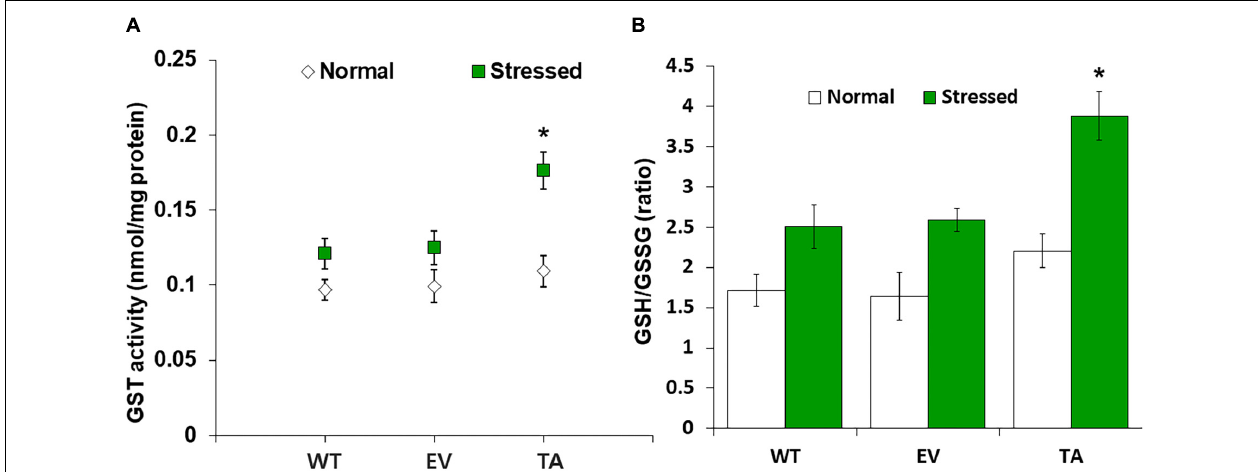
FIGURE 5 | Analysis of enzyme activity and antioxidant redox status in TA after H 2 O 2 treatment. (A) Activity of GST under normal and stress conditions. (B) Intracellular GSH/GSSG redox ratios in WT, EV, and TA after exposure to 2.5 mM H 2 O 2 for 24 h. White bars correspond to conditions before H 2 O 2 treatment (normal conditions), and the GSH/GSSG redox ratios (green bars) correspond to conditions after H 2 O 2 treatment (stress conditions). Data are shown as mean values ± SD of biologically least three independent experiments. Asterisks indicate significant differences between treatments as estimated by Student’s t -test ( P < 0.05). Measurements are an annotated in Supplementary Figure S1 .